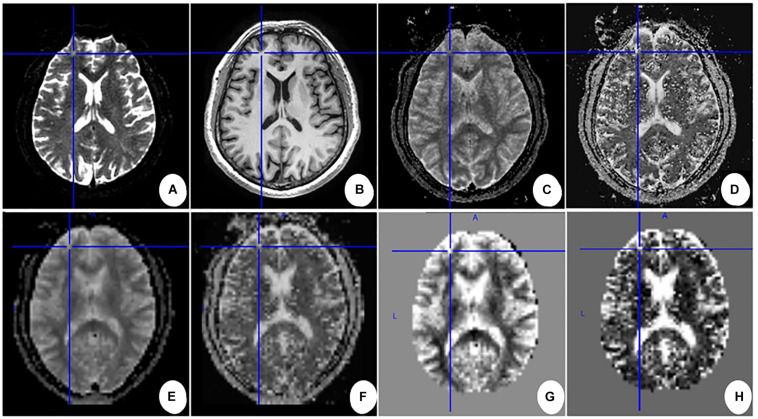
Main data pre-processing work flow for one subject. (A) First b0-volume; (B–D) 3D T1 images, Ds maps, and f maps after being coregistered to the first b0-volume. (E,F) Ds maps and f maps in the MNI space after normalizing. (G,H) The Z-normalized Ds maps and f maps after removing the skull. Cross lines are shown to help comparison between images.